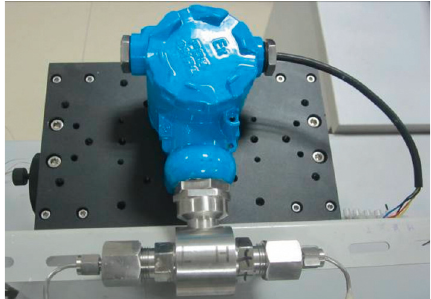
Figure 4: Differential pressure sensor (type: